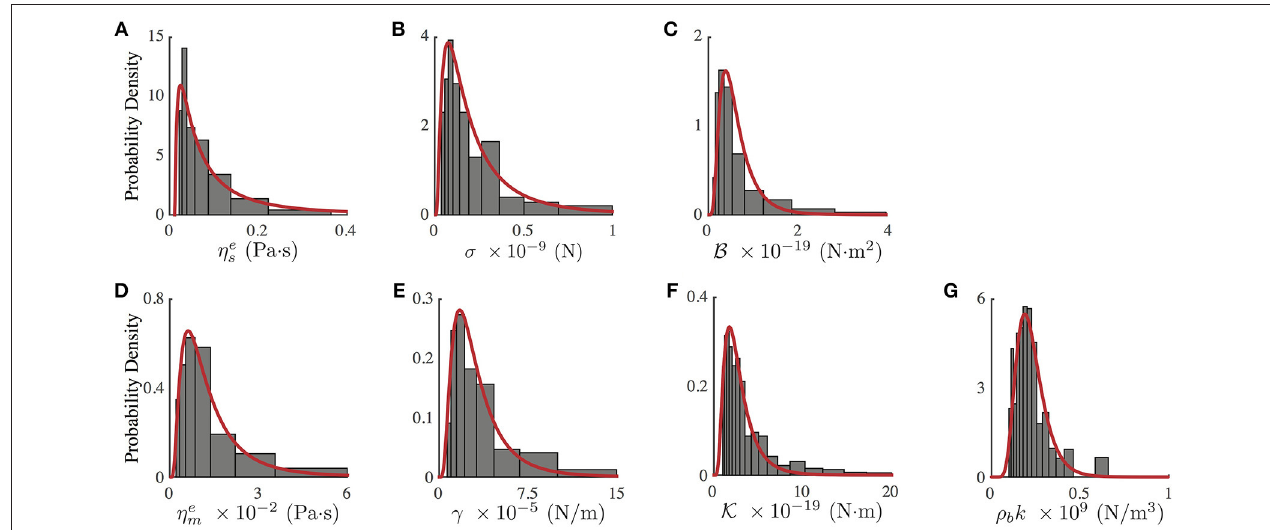
FIGURE 4 | Probability density distribution of mechanical parameters of PC12 neurites, obtained from the fit of the experimental and theoretical PSD (Equation 3, Figure 2C red continuous line). (A) Effective neurite viscosity η e s . (B) Neurite axial tension σ . (C) Neurite flexural rigidity B . (D) Effective membrane viscosity η e m . (E) Membrane surface tension γ . (F) Membrane bending rigidity K . (G) Membrane to cytoskeleton coupling ρ b k . All experimental probability distributions were fitted by a Log-Normal distribution. N = 75 neurites of similar radius and length.